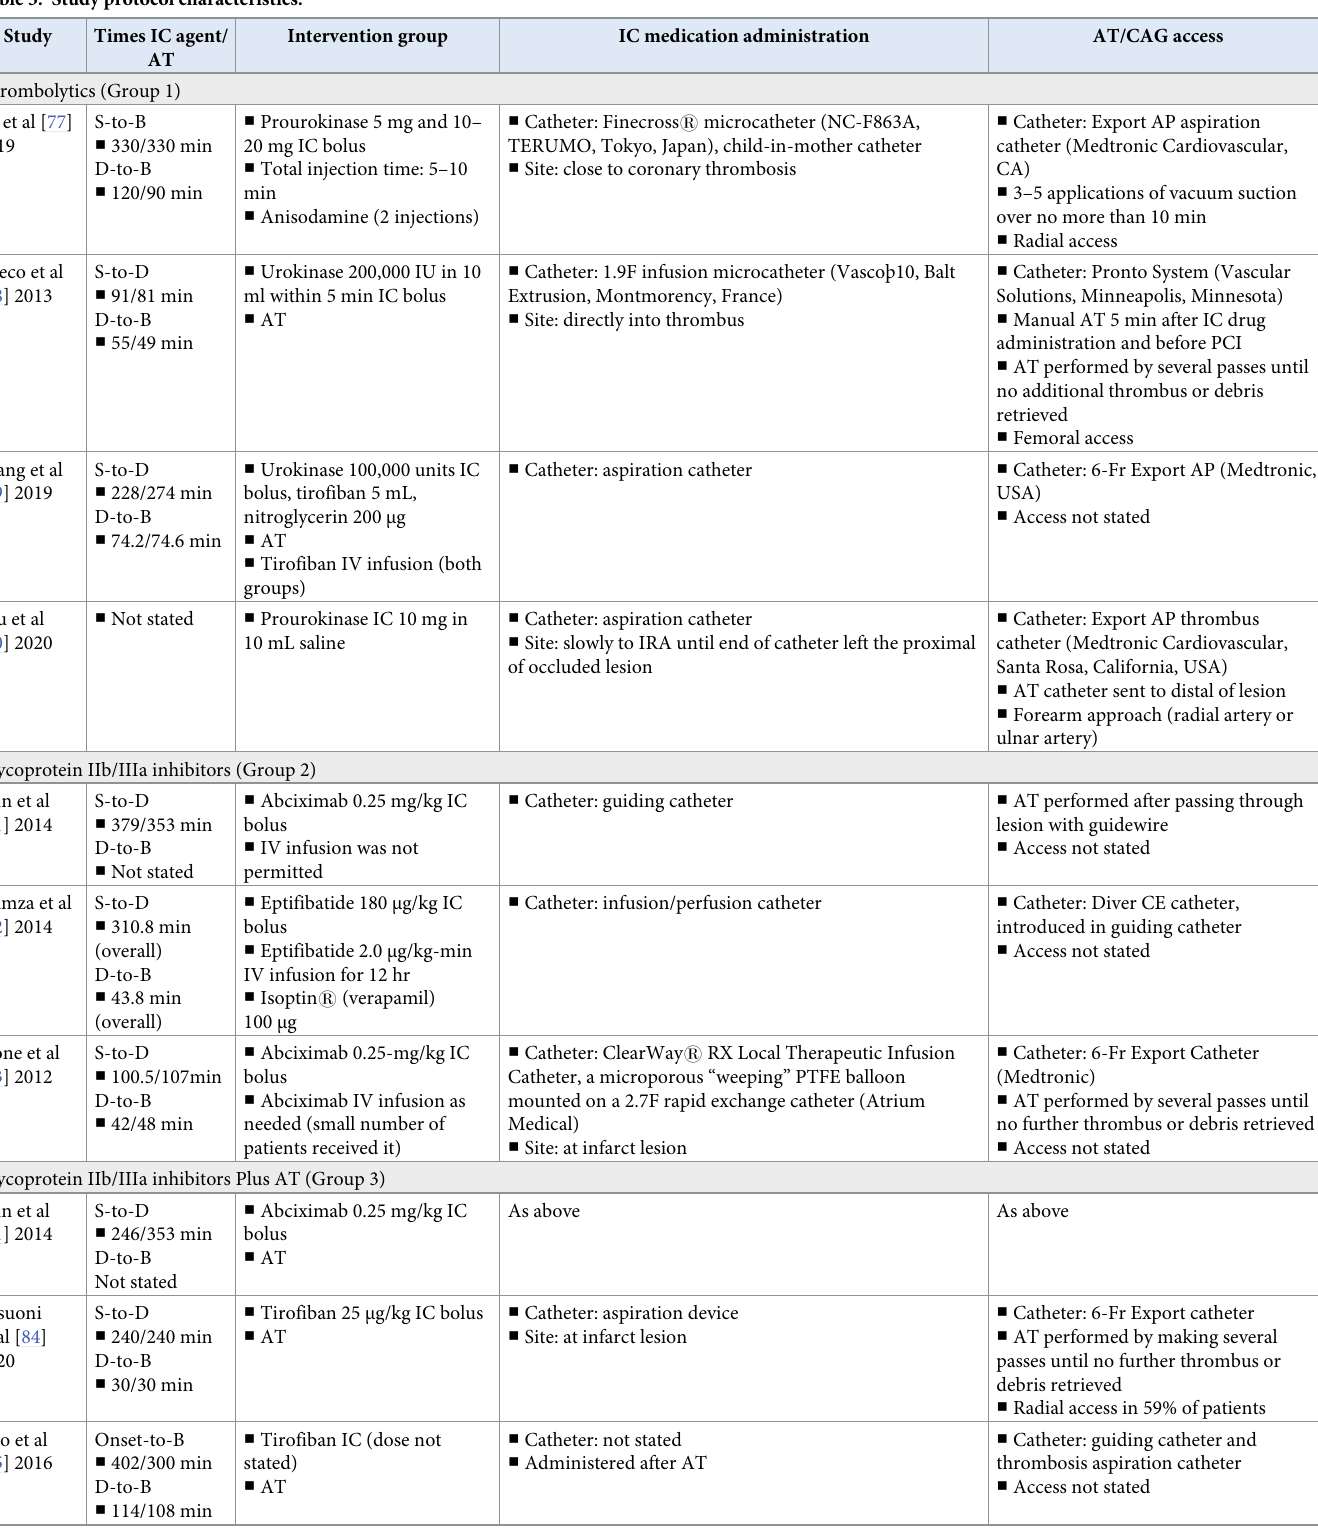
Table 3. Study protocol